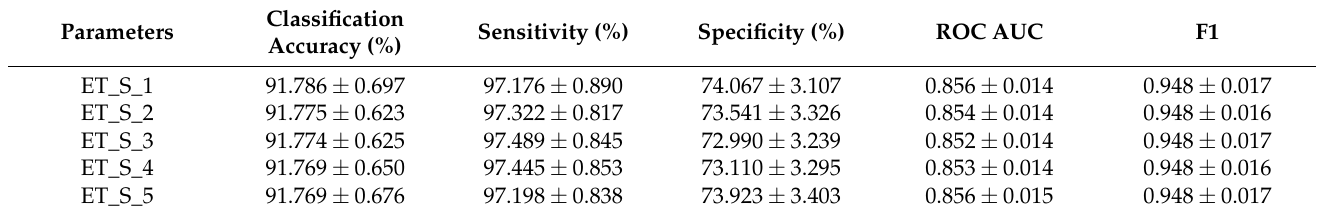
Table 6. Best results for the extremely randomized trees algorithm (static analysis).